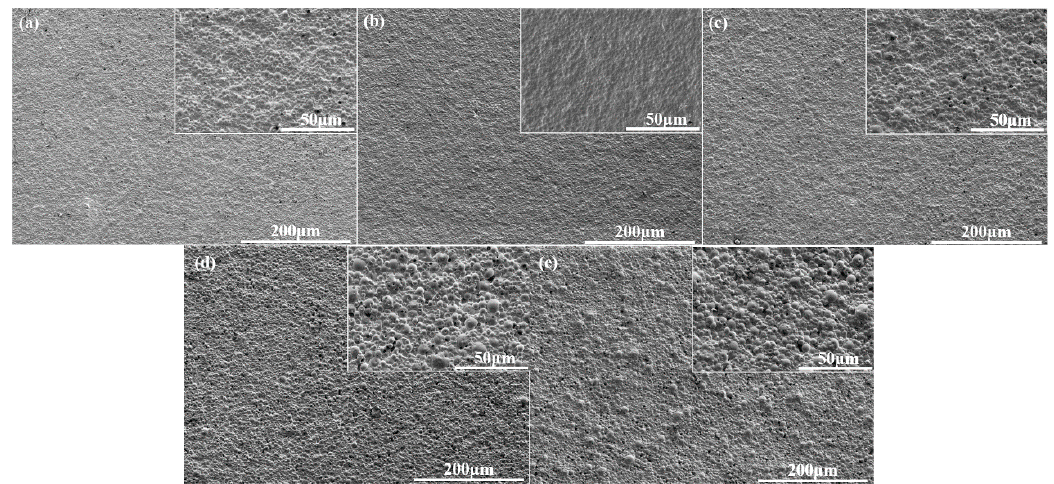
Figure 9. SEM micrographs of WPU-H films with different hard segment contents: ( a ) 33%; ( b ) 35%; ( c ) 37%; ( d ) 39%; ( e ) 41%.